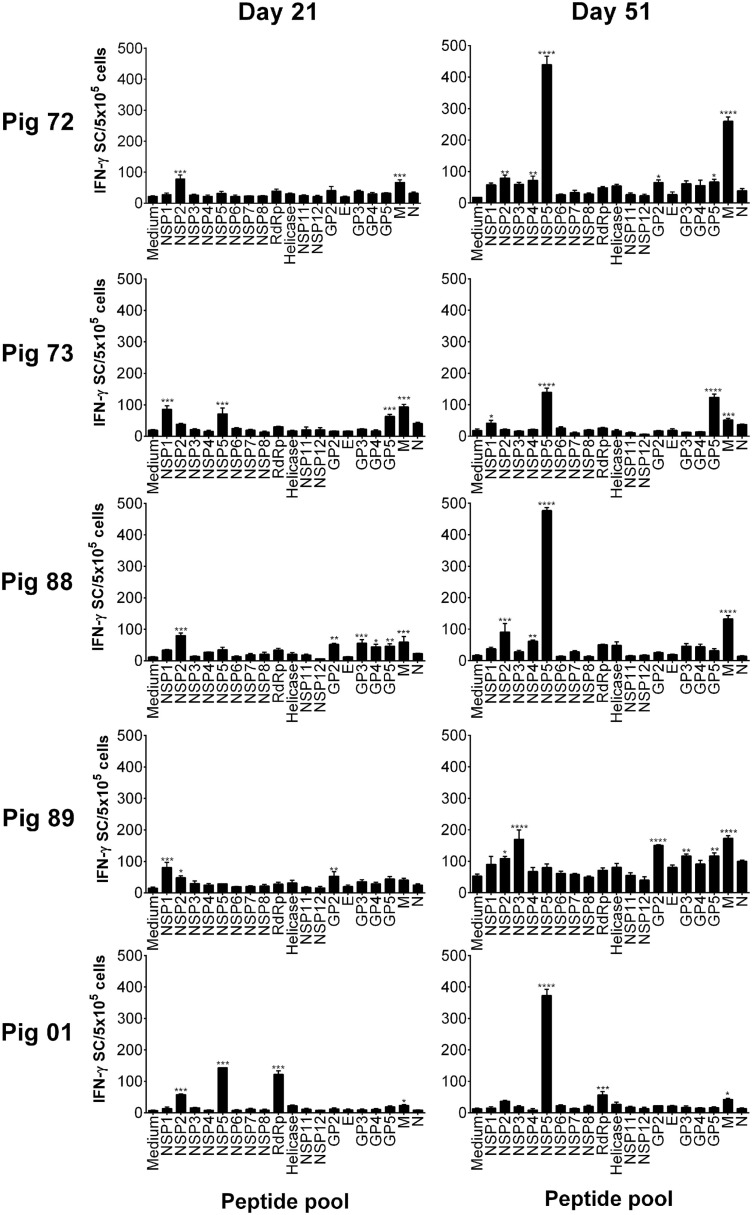
Recognition of PRRSV-1 proteins by T cells from pigs experimentally infected with the SU1-Bel strain. PBMC from pigs experimentally infected with PRRSV-1 SU1-Bel (n = 5) were isolated on day 21 and day 51 postinfection (16 days post-challenge), and stimulated in vitro with synthetic peptides pooled to represent 19 PRRSV-1 proteins. IFN-γ secreting cells were enumerated by ELISpot assay. Data are presented as IFN-γ spot forming cells (SFC)/5 × 105 PBMC (triplicate cultures) for each animal and error bars show the SEM. Values for each peptide pool-stimulated condition were compared to the corresponding unstimulated (medium) control using a one-way ANOVA followed by a Dunnett’s multiple comparison test; ***p < 0.001, **p < 0.01, and *p < 0.05.